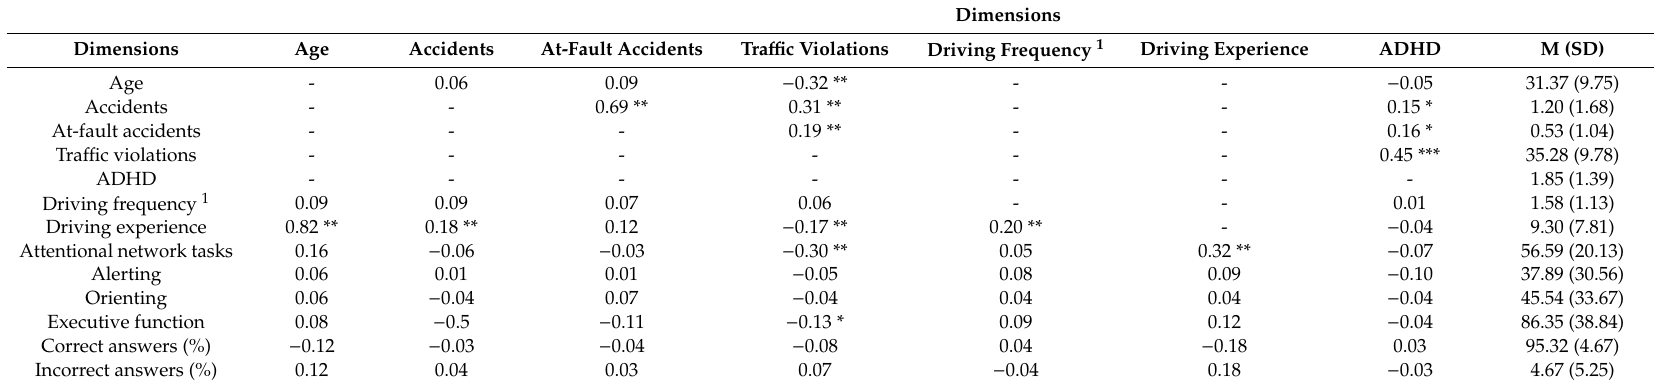
Table 1. Descriptive and correlative statistical indices of demographic driving-related information, symptoms of attention-deficit / hyperactivity disorder (ADHD), attentional network tasks and its